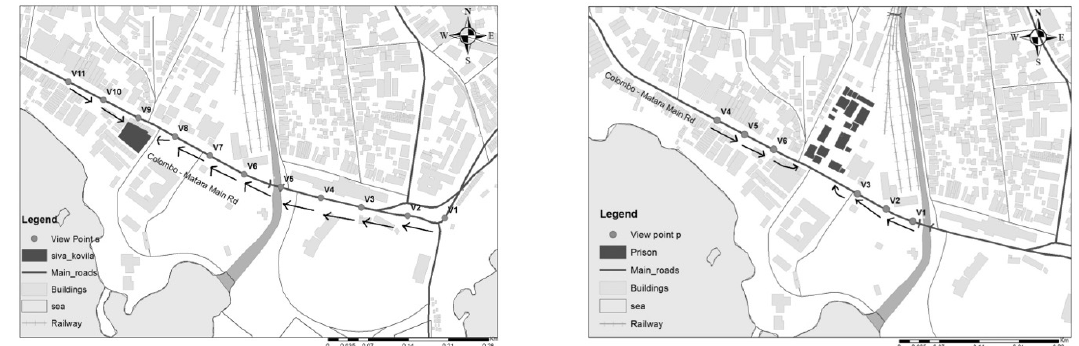
Figure 6. Viewpoints of the landmarks from H2 (Left: Cricket stadium; right: Municipal council building)